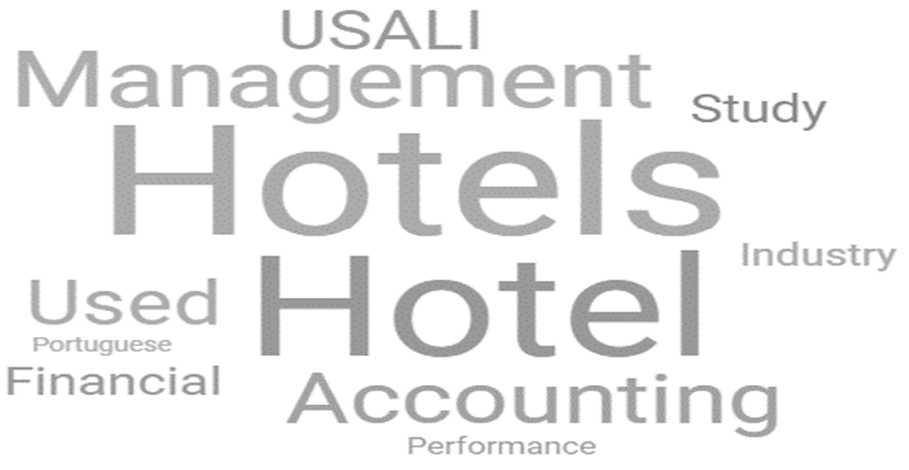
Figure 10. Abstracts’ word cloud.